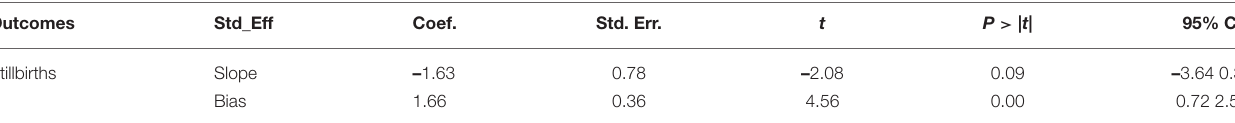
TABLE 5 | Egger’s test to show publication bias.